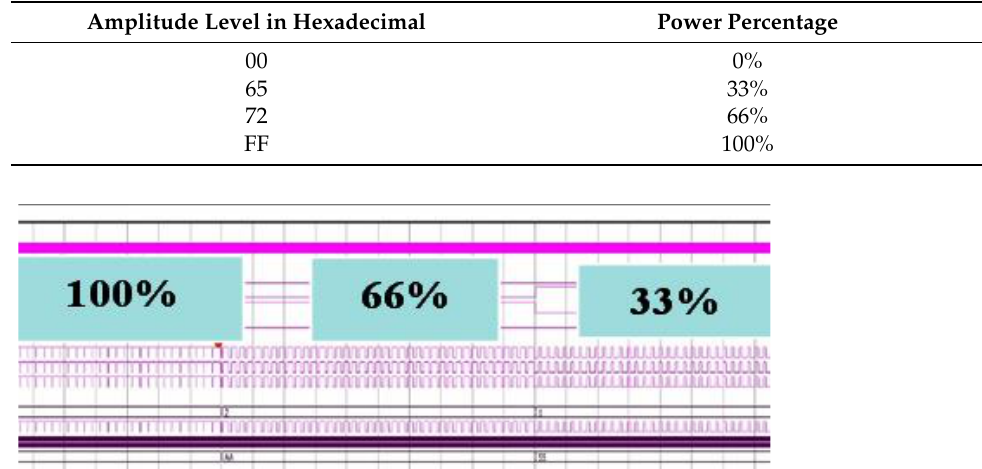
Table 3. PWM Levels.